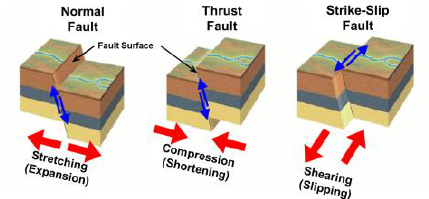
Figure 6. Opening fault surfaces according to fault